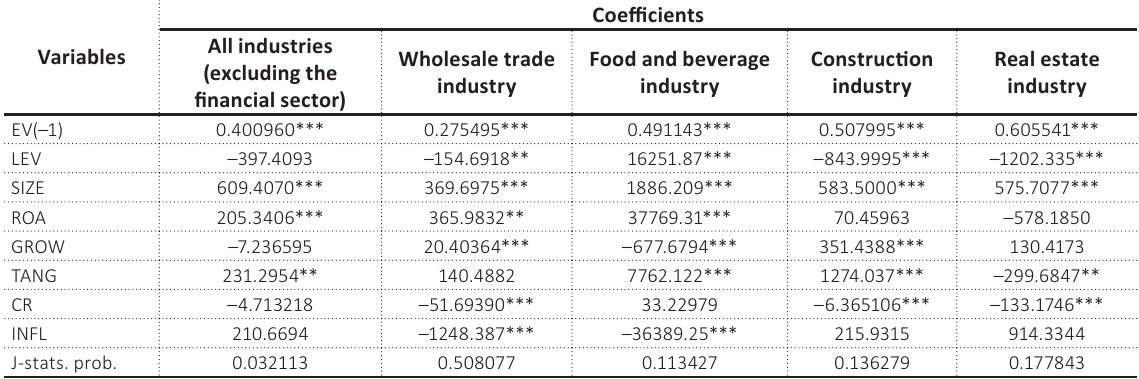
Table 3. Empirical results using